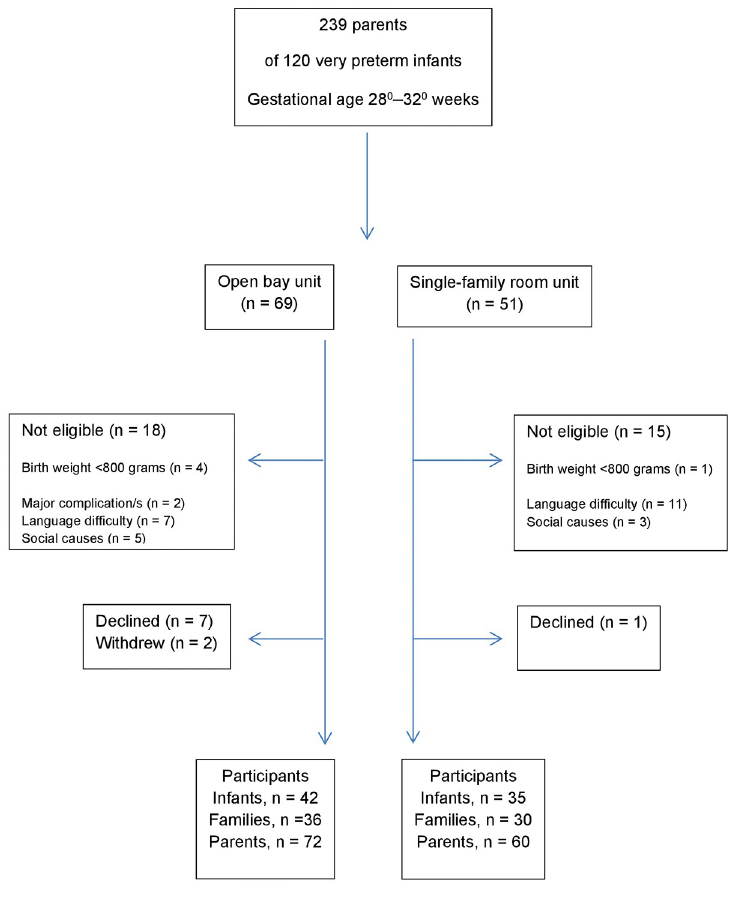
Fig 1. Flow diagram of participant